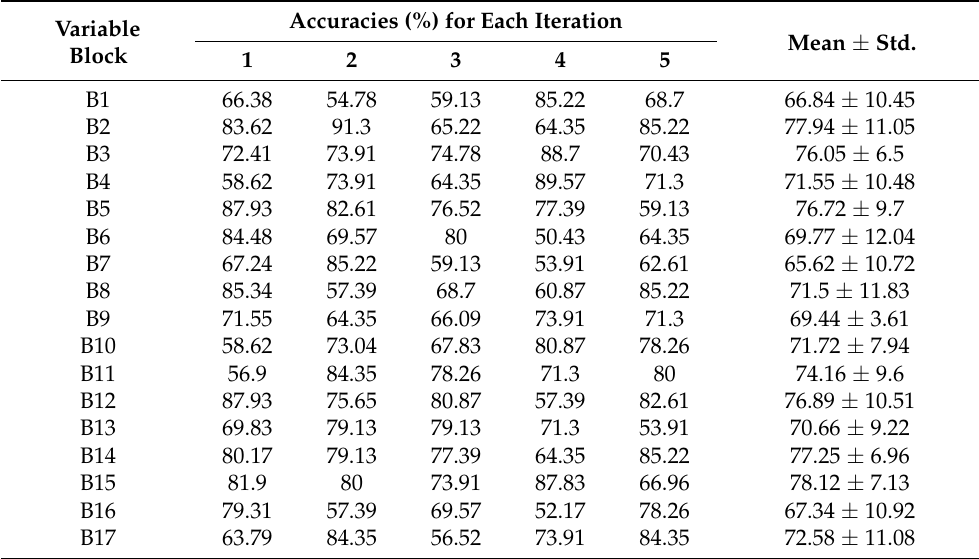
Table 12. Accuracies of different network structure of the proposed dataset for valence classification. The training and test were repeated five